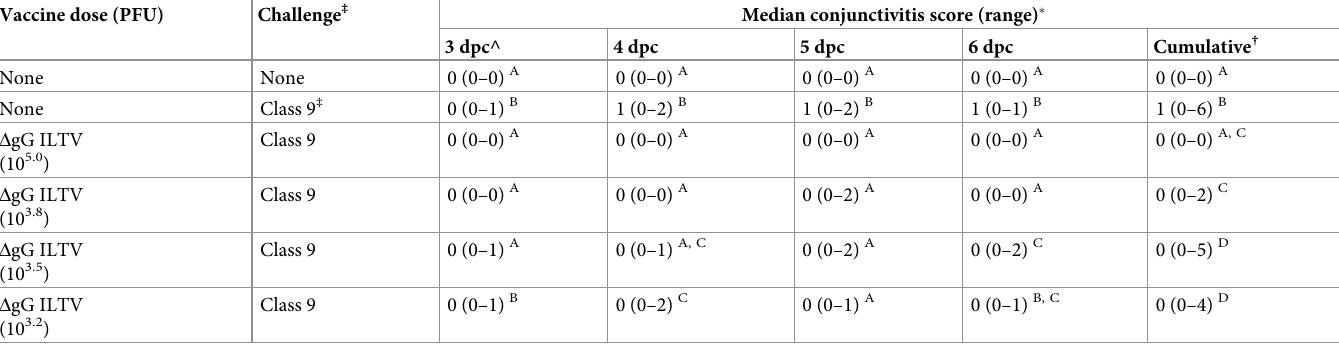
Table 2. Scores for conjunctivitis on days 3 to 6 after challenge in unvaccinated birds and in birds vaccinated with different doses of Δ gG ILTV vaccine administered via eye-drop. Vaccine dose